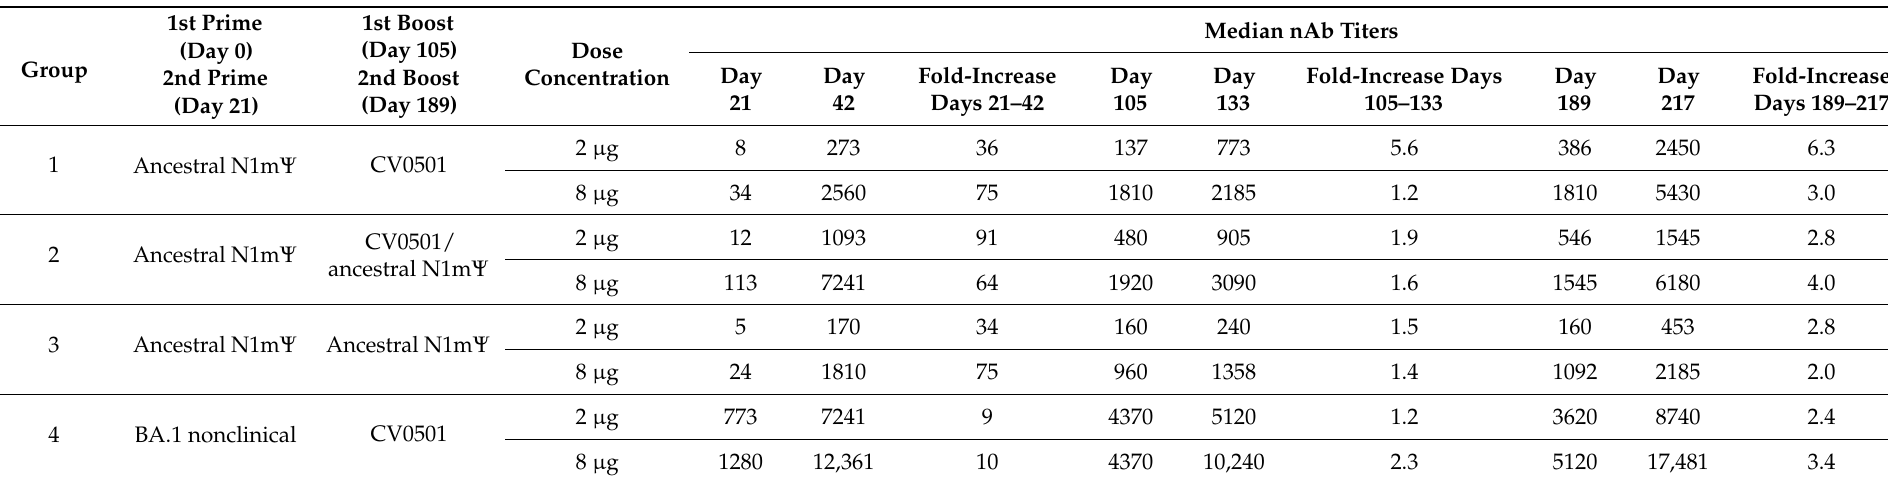
Table 2. Analyses of median nAb production against SARS-CoV-2 variant BA.1 after booster vaccination with CV0501 alone, ancestral N1m Ψ alone or bivalent CV0501/ancestral N1m Ψ